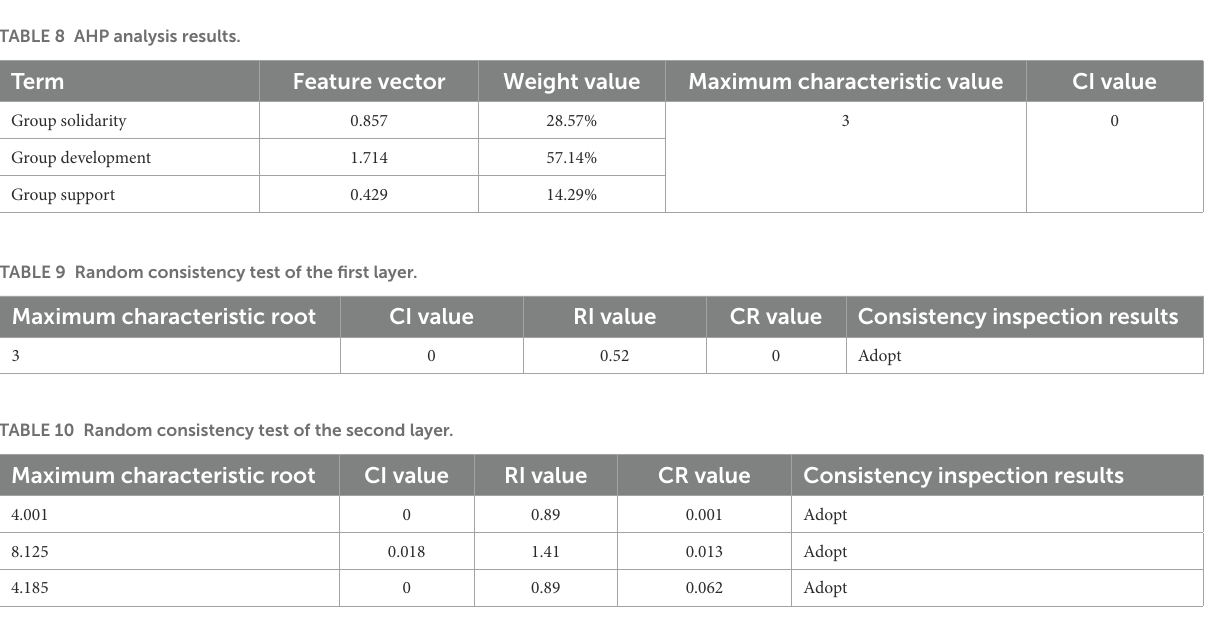
TABLE 11 Weights of key